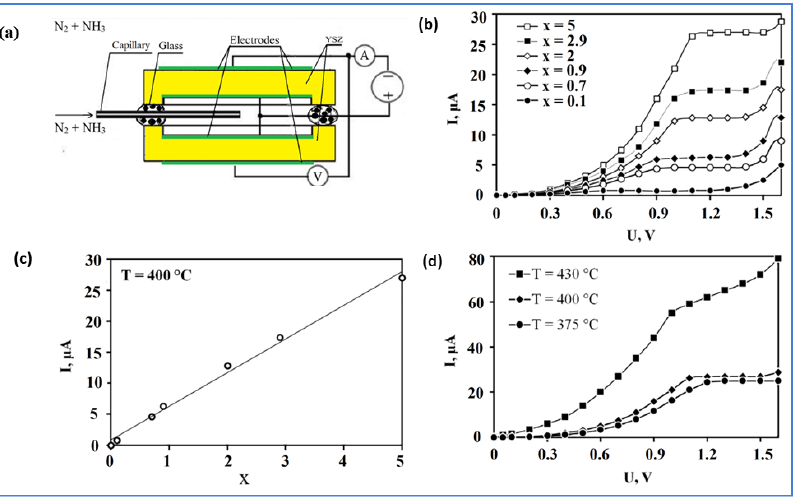
Figure 6. ( a ) Schematic representation of a NH 3 amperometric sensor. Reproduced with permission from [64]. ( b ) Current response on the applied voltage for different ammonia concentrations at 400 °C. x is the NH 3 concentration in vol.%. ( c ) The relation between the limiting current and different NH 3 concentrations and ( d ) current–voltage curves for different temperatures for 5 vol.% ammonia. Reproduced with permission from [64].